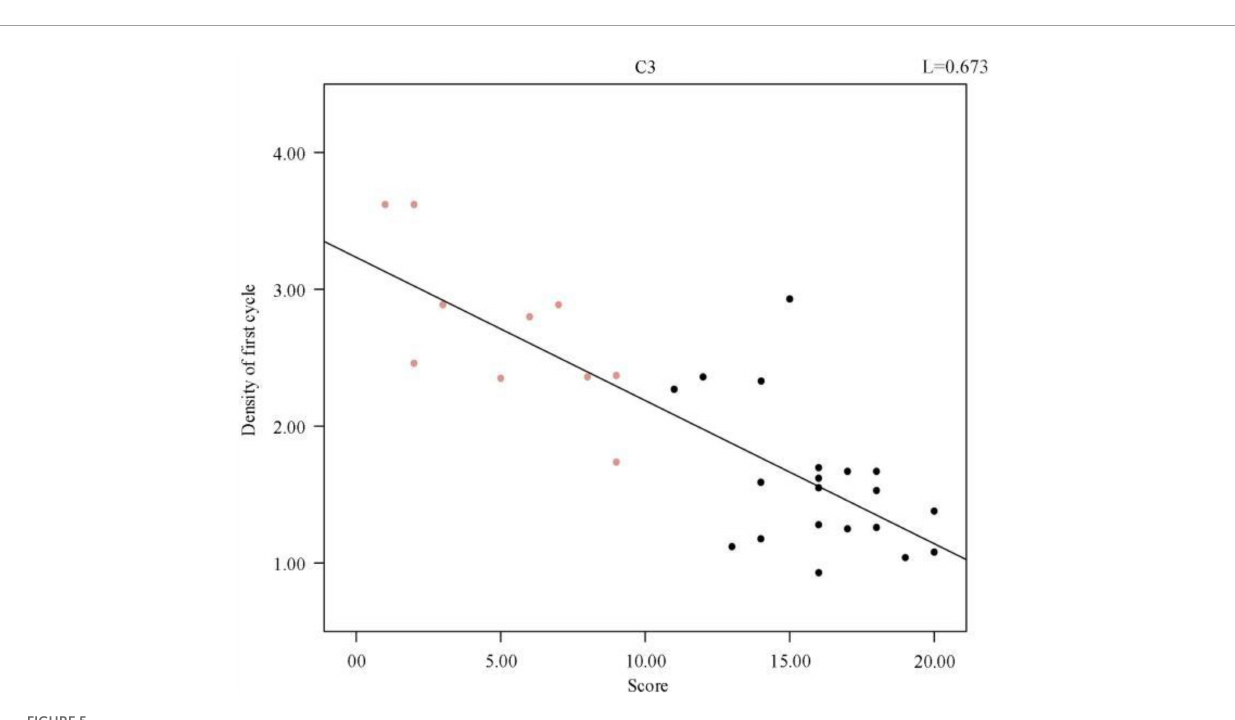
population samples and 50.3% of the spindles distributed between 20 and 40 µ V in the normal population samples. Between 20 and 30 µ V, the proportion of spindles was 14.2% higher in the sleep- disordered population than in the normal population.